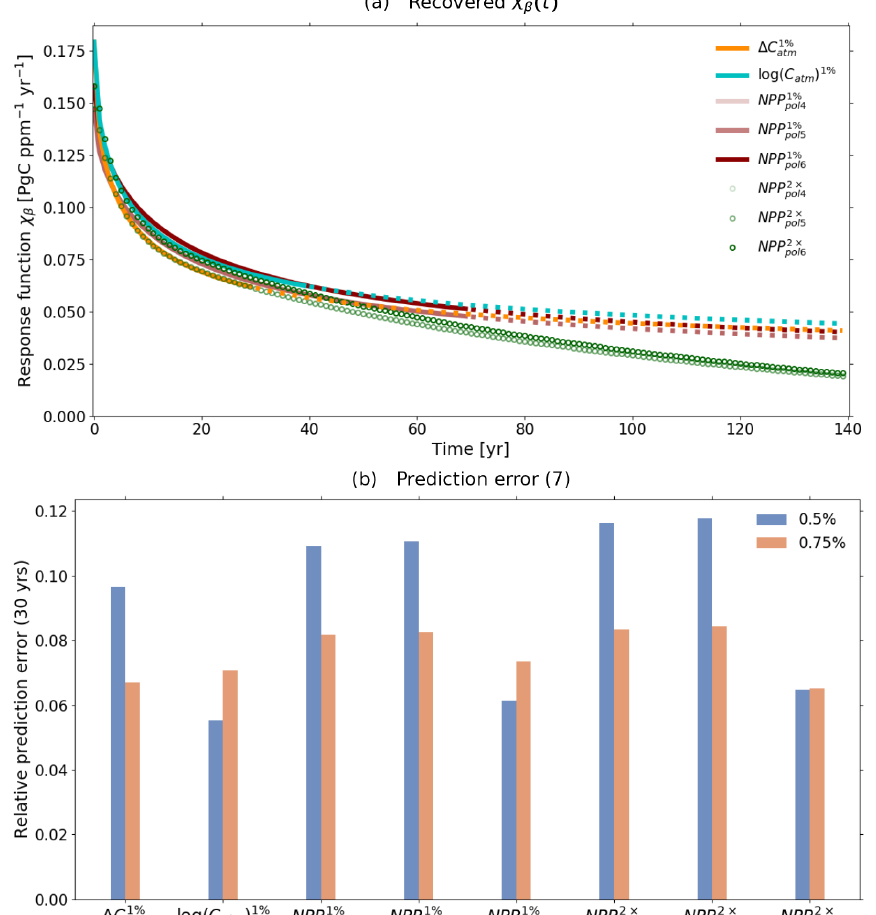
Figure 7. Response function χ β (t) derived by the three approaches (a) and the respective prediction errors for the first 30 years of the response (b) . (cid:49)C 1% atm : recovery with first approach from 1% bgc experiment; log (C atm ) 1% : recovery with second approach from the 1% bgc experiment; NPP 1% : recovery with third approach from the 1% bgc experiment using for the derivative a polynomial fit of order x ; pol x NPP 2 × : recovery with third approach from the 2 × CO 2 bgc experiment using for the derivative a polynomial fit of order x . Continuous pol x lines denote values of χ(t) that are within the time series length used for the recovery (30 years for (cid:49)C 1% atm , 40 years for log (C atm ) 1% and 70 years for NPP 1% ). Dotted lines denote extended parts of the response function, i.e., values not covered by the time series used for the pol x recovery but obtained from the recovered spectrum using Eq. (5). Circles denote the response functions derived taking the full time series (NPP 2 × ). For more details, see pol x